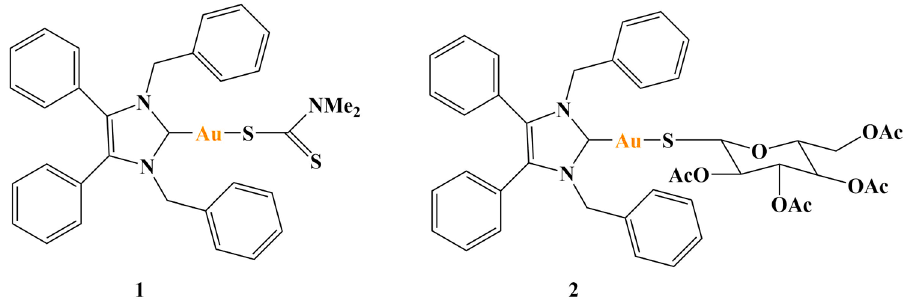
Figure 26. The complexes presented in [104].